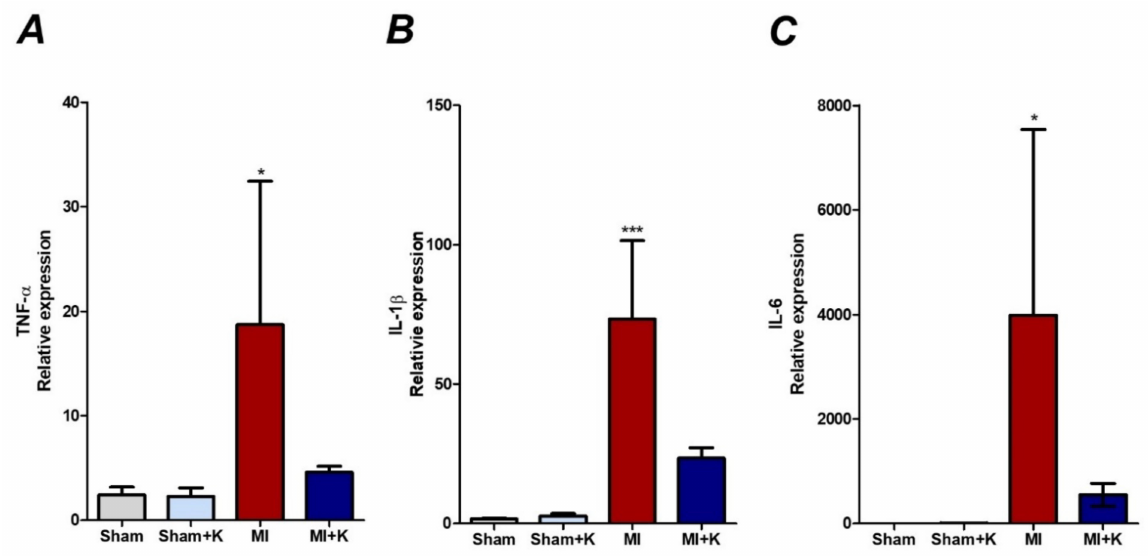
Figure 4. Cardiac mRNA expression of three major inflammatory cytokines in the peri-infarcted regions. ( A ) Quantification of the expression of tumor necrosis factor- α (TNF- α ) by RT-PCR, * p < 0.05, comparison of myocardial ischemic/reperfusion (I/R) injury treated with klotho by one-way analysis of variance (ANOVA) followed by Bonferroni post hoc test. ( B ) Quantification of interleukin-1 β (IL-1 β ) expression by RT-PCR, *** p < 0.001. Comparison of myocardial I/R injury treated with recombinant klotho (rKL) by ANOVA followed by Bonferroni post hoc test. ( C ) Quantification of IL-6 expression by RT-PCR, * p < 0.05. Comparison of myocardial I/R treated with klotho by ANOVA followed by Bonferroni post hoc test (the number of animals: n = 5,